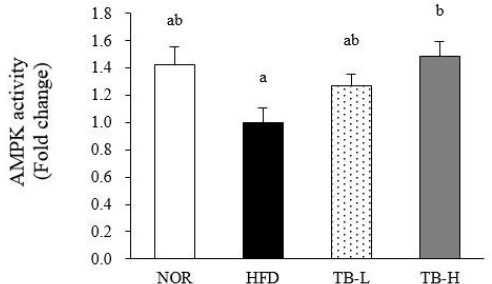
Figure 5. AMP-activated protein kinase (AMPK) activity in adipose tissue. AMPK activity was measured in white adipose tissue. Data are expressed as mean ± SEM ( n = 8). Values with different letters are significantly different at p < 0.05. NOR: normal diet; HFD: 45% high-fat diet; TB-:, HFD + 0.5% TB; TB-H: HFD + 1.0% TB.